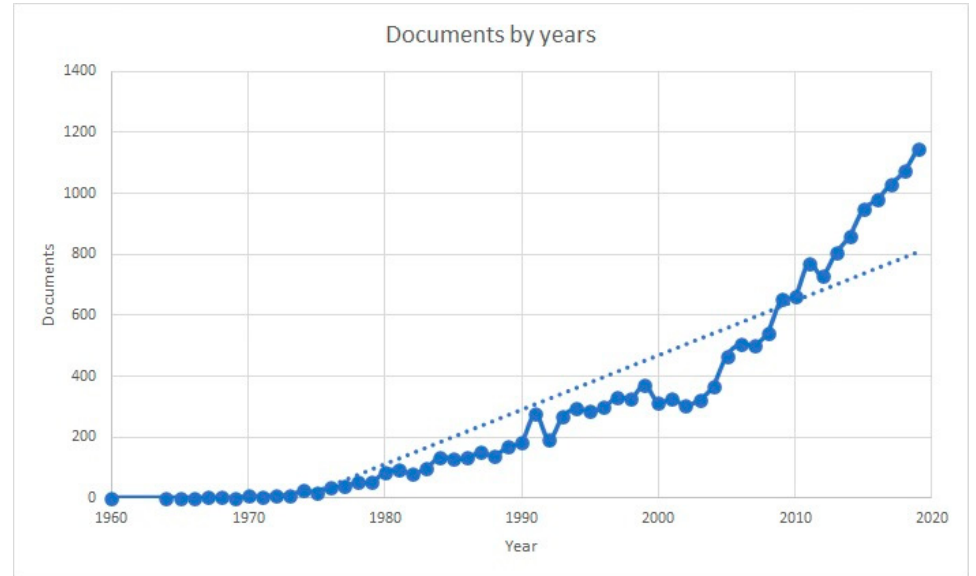
Figure 4. Annual production of CPR publications.